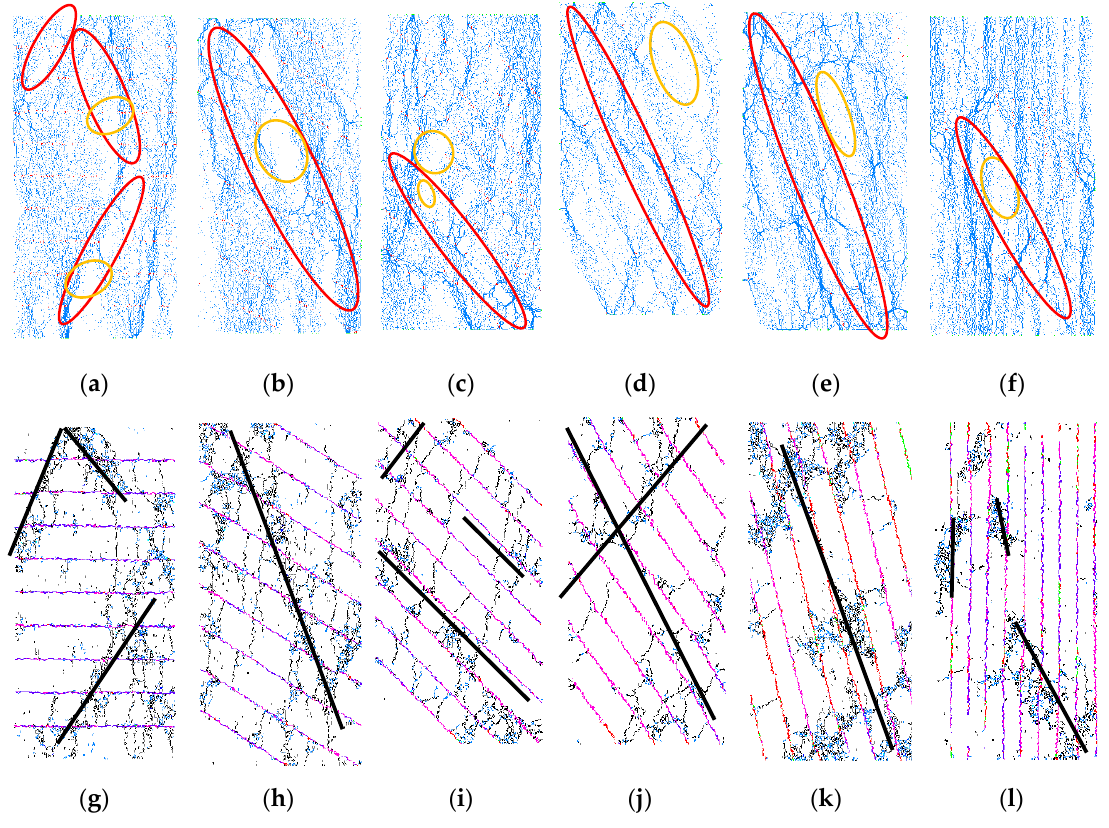
Figure 16. Failure pattern of coal with different bedding angles. ( a ) Contact force chain of 0°; ( b ) Contact force chain of 30°; ( c ) Contact force chain of 45°; ( d ) Contact force chain of 60°; ( e ) Contact force chain of 75°; ( f ) Contact force chain of 90°; ( g ) Main cracks of 0°; ( h ) Main cracks of 30°; ( i ) Main cracks of 45°; ( j ) Main cracks of 60°; ( k ) Main cracks of 75°; ( l ) Main cracks of 90°.